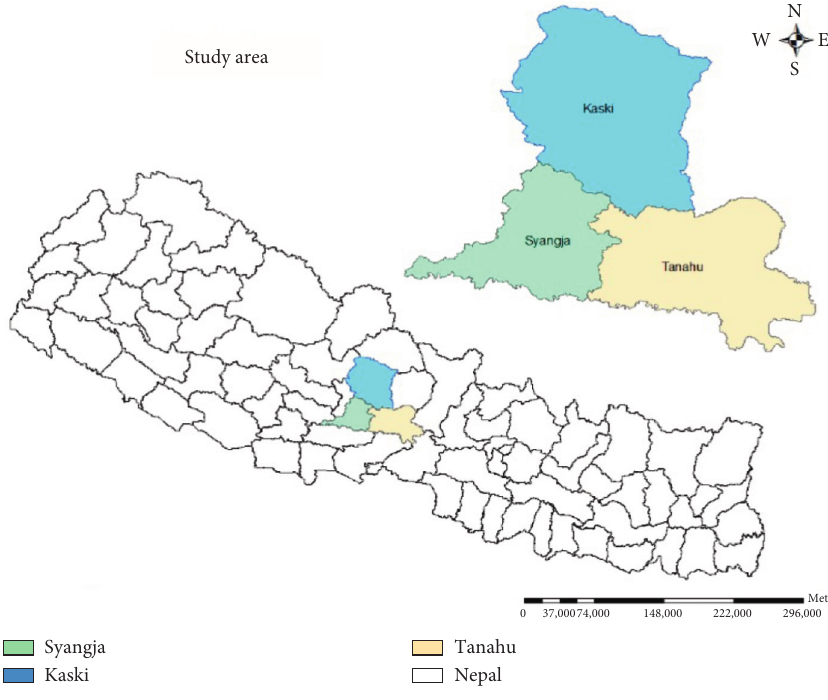
Figure 1: Study area showing three districts of midhills of